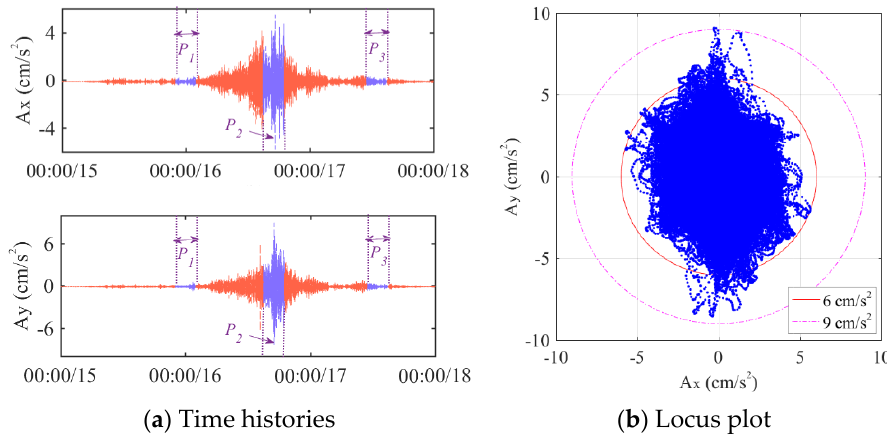
Figure 6. Time histories of acceleration responses at the 58th floor of Leatop Plaza.